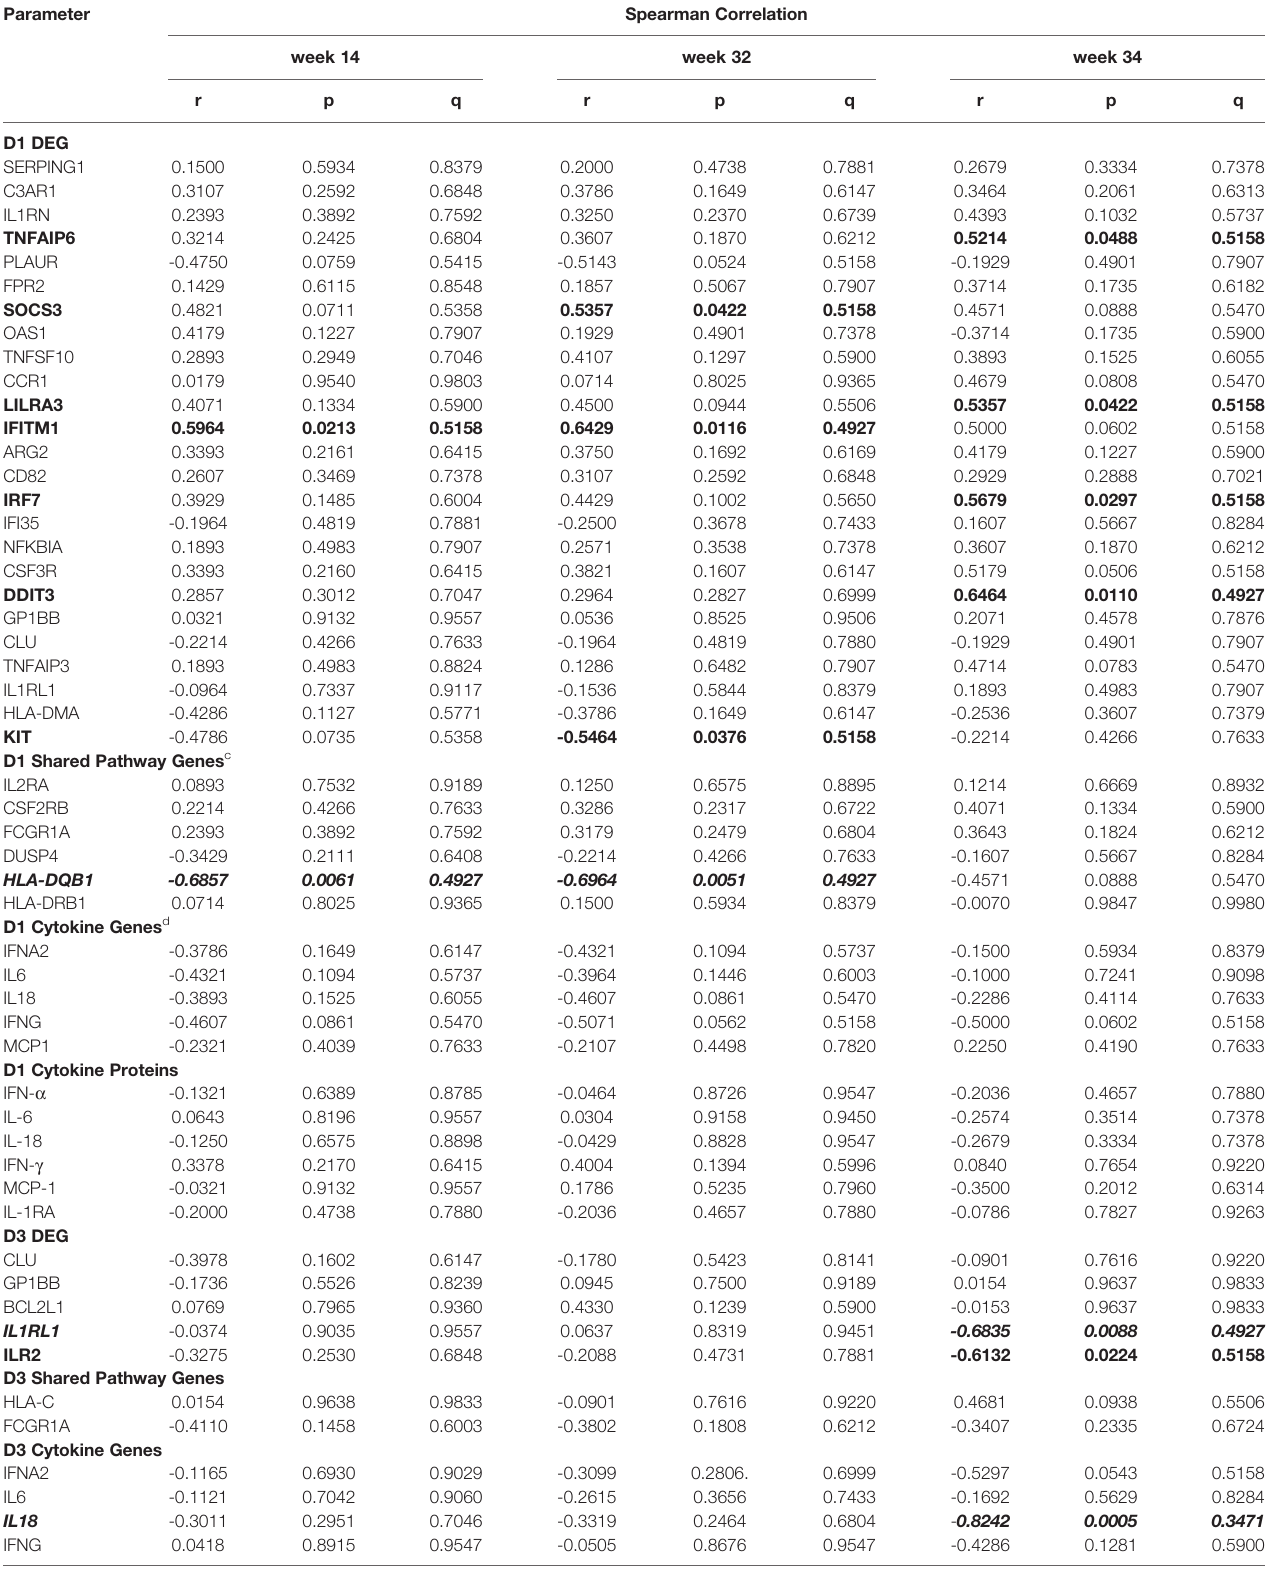
TABLE 3 | Correlation of early gene expression with vaccine-induced Env-speci fi c neutralizing